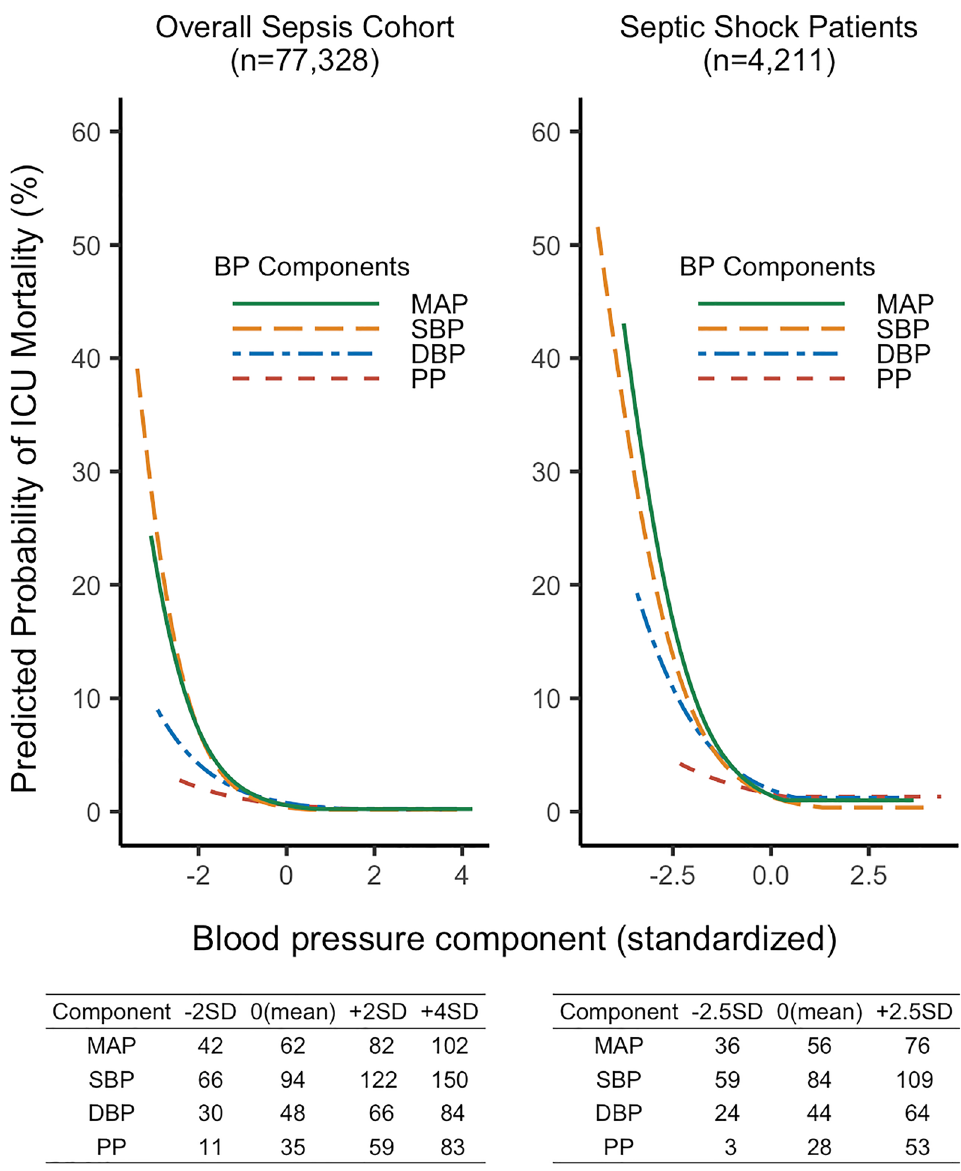
Fig. 3 Predicted probabilities of ICU mortality under the hinge model with a single